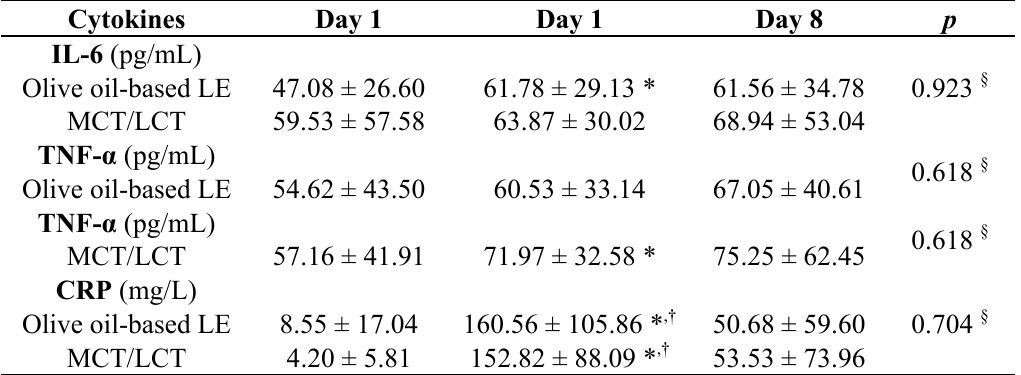
Table 6. Comparison of proinflammatory indicators between the two